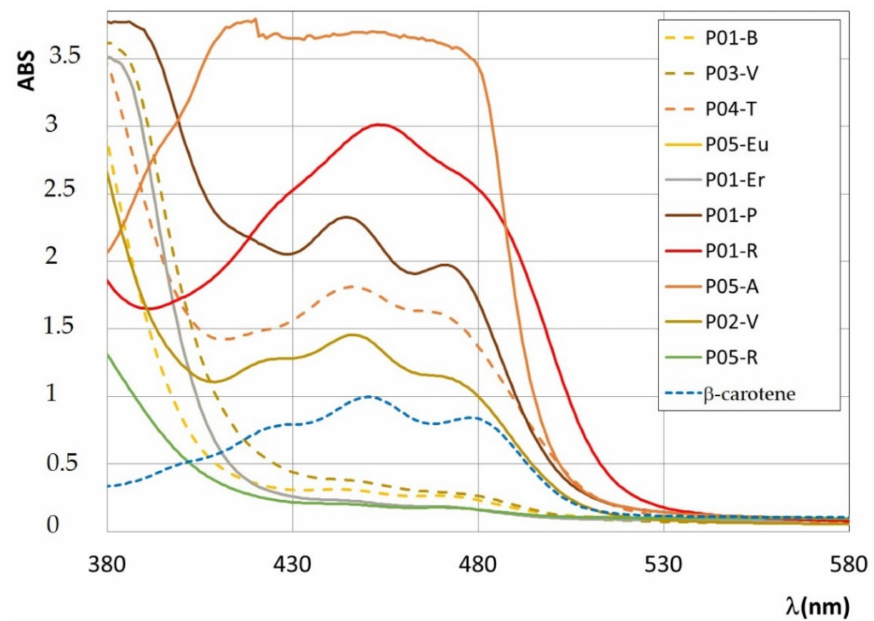
Figure 2. UV-vis absorption spectra of ethanol extracts of the bee pollen samples, as described in the text. The UV-vis spectrum of a solution of β -carotene in ethanol (C = 0.24 mg / mL) is reported for a direct